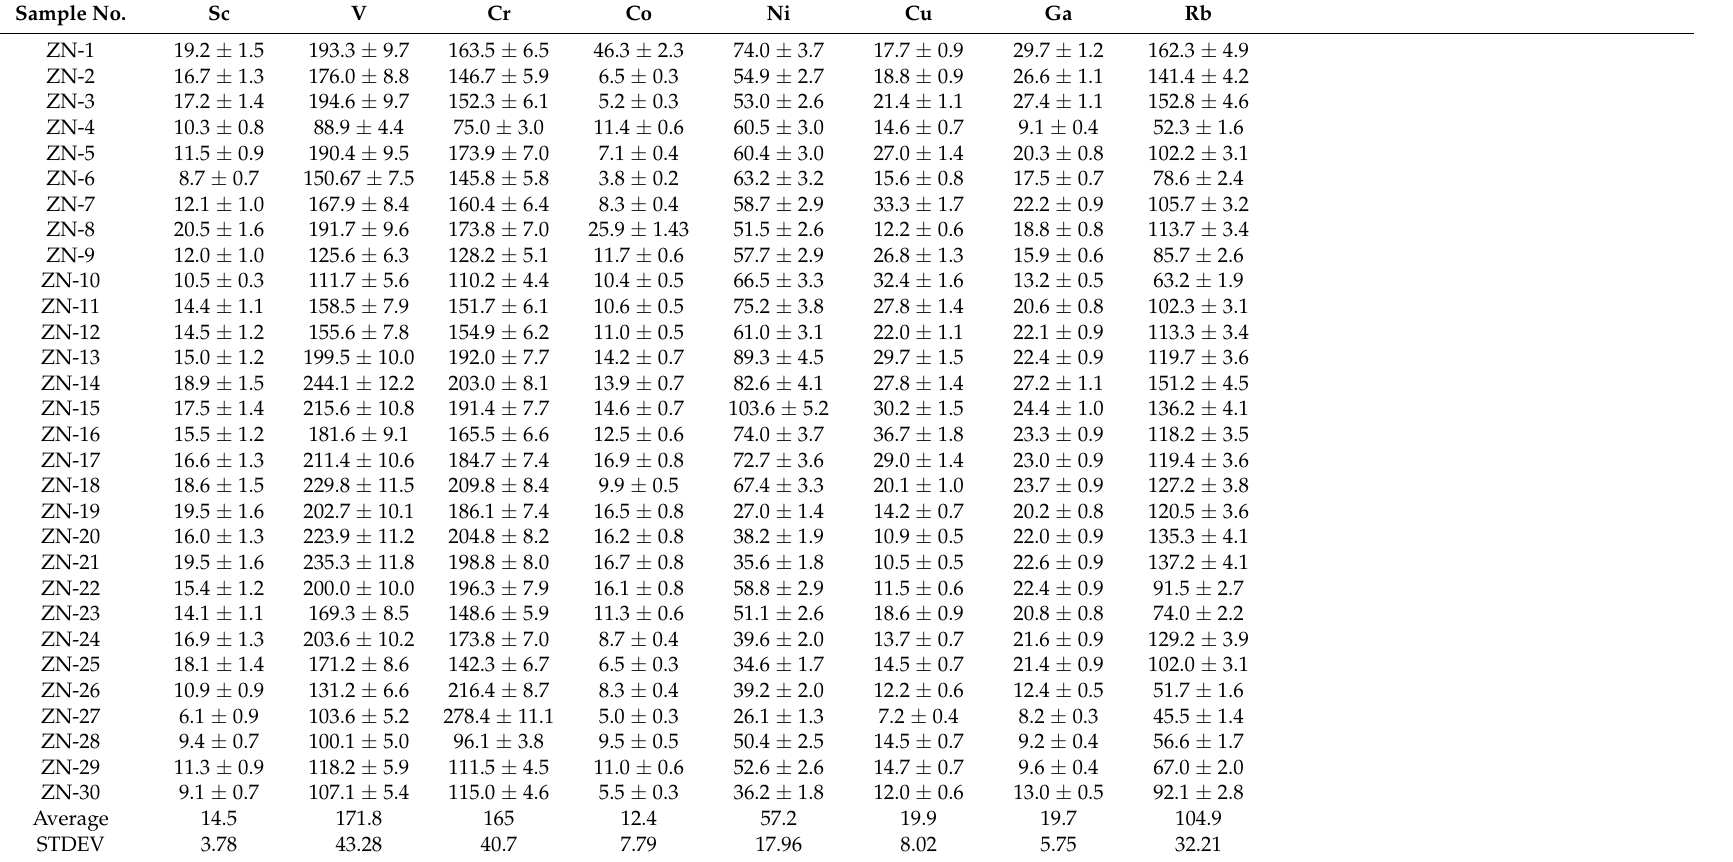
Table 2. Concentrations of selected trace elements (ppm) and their ratios of Datang Formation black rock series. Sample